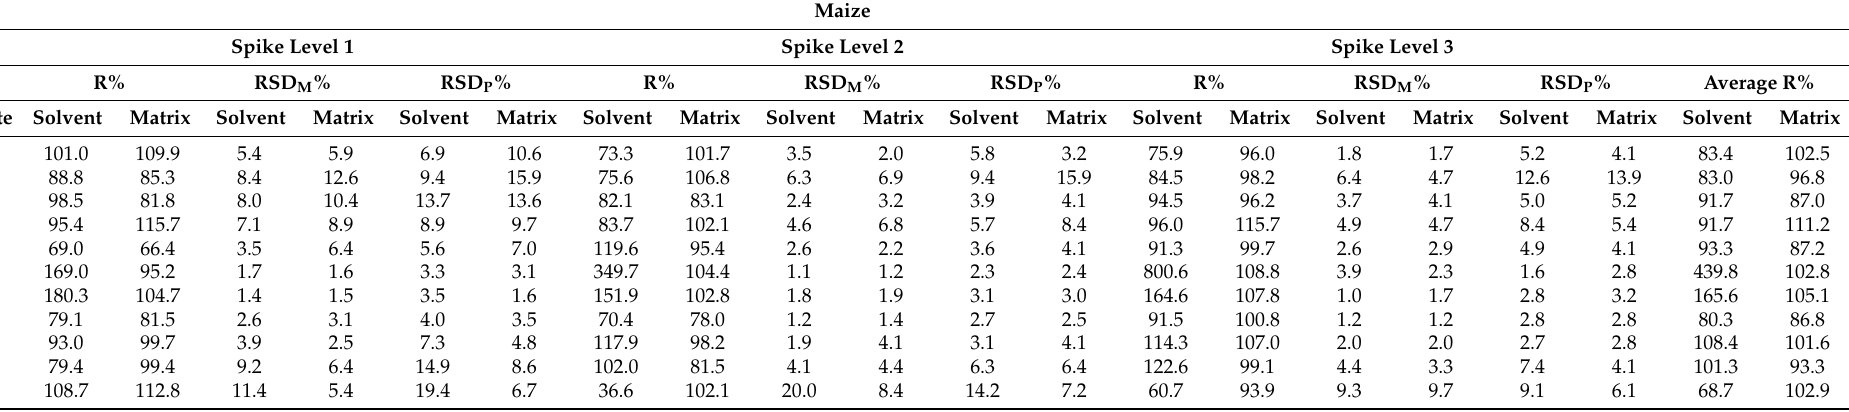
Table 7. Method recovery (R%) and repeatability of measurement (RSD M %) and sample preparation (RSD P %) in maize using solvent and matrix-matched calibration.